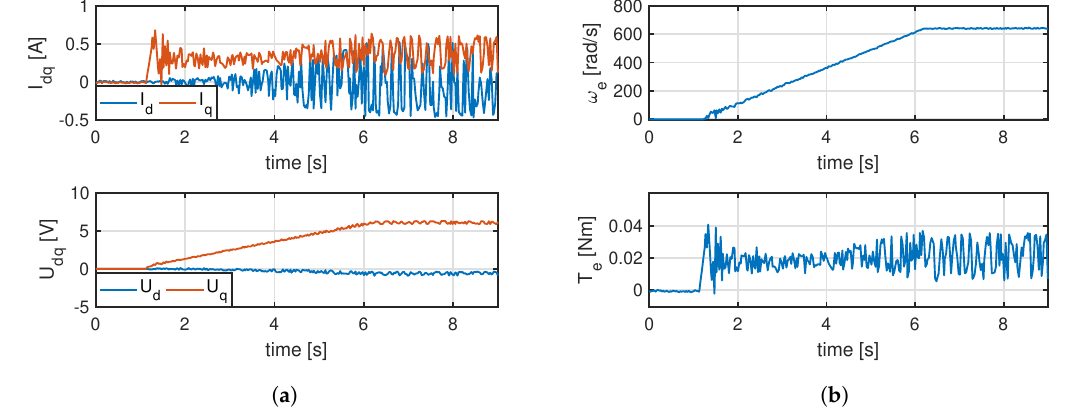
Figure 19. ( a ) dq currents and voltages; ( b ) ω e and T e during start-up sequence of Figure 18.